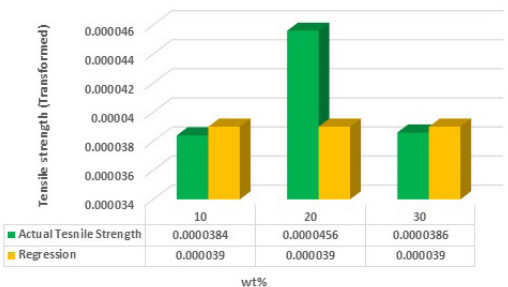
Figure 9. A comparison between the regression equation and the actual value of the tensile strength of untreated hemp-PP